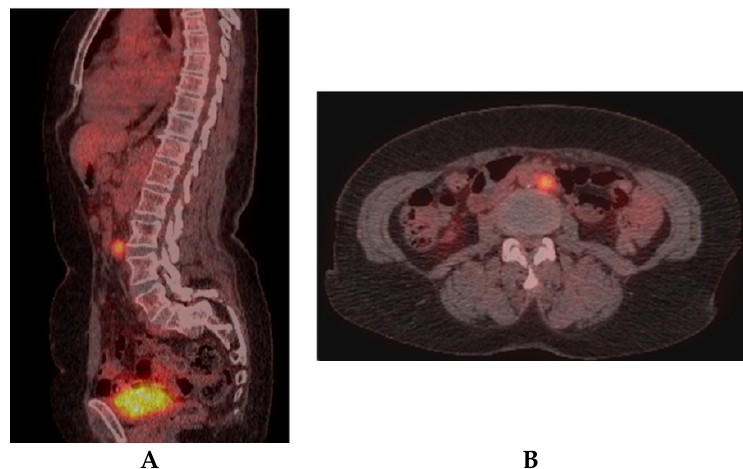
Figure 6. F18-FDG PET / CT scans in 2017 after treatment, evaluating the CA 125 increase during the follow-up: sagittal section abdominal level ( A ), pelvic level ( B ) showing tracer high uptake in left abdominal latero-aortic lymph node (SUVlbm Max—4.43), with recurrence after complete remission in 2016.